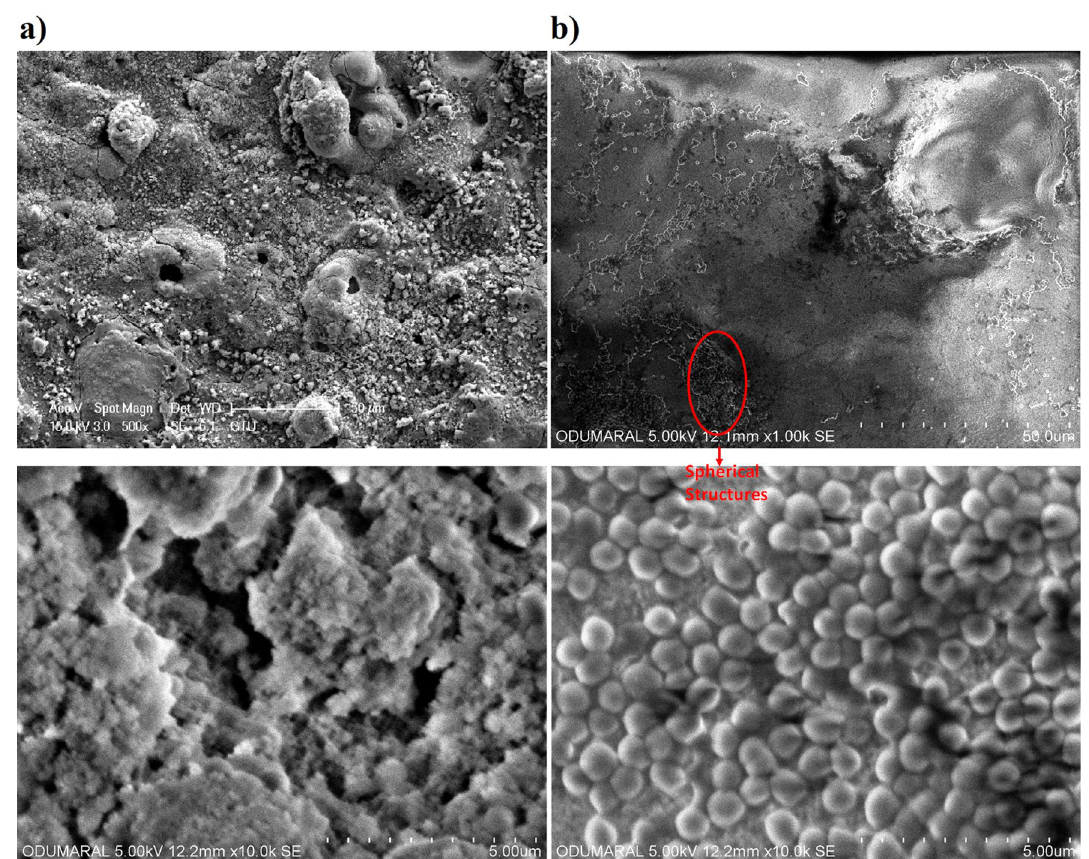
Figure 3. SEM images of the coatings with low and high magnifications: ( a ) the MAO and ( b ) chitosan-based MAO